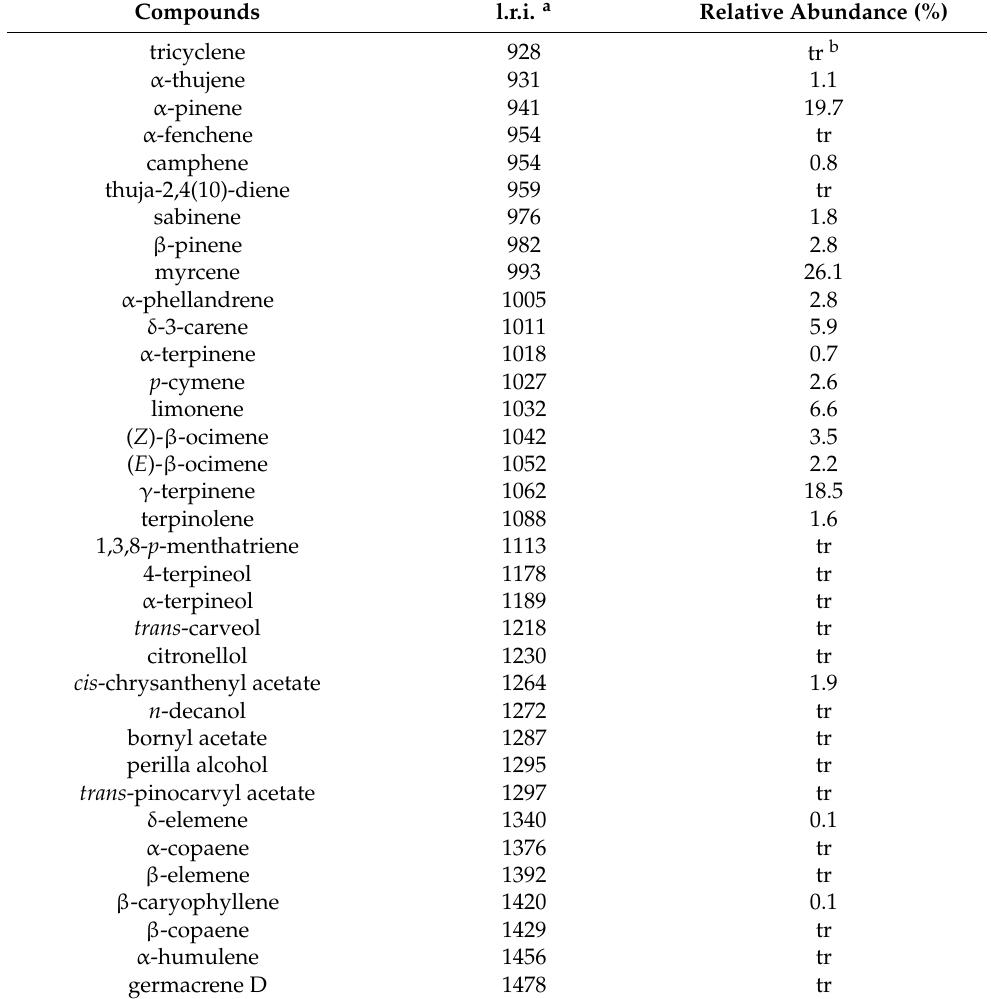
Table 1. Complete composition of the essential oil hydrodistilled from ripe fruits of Ferulago campestris (Besser)